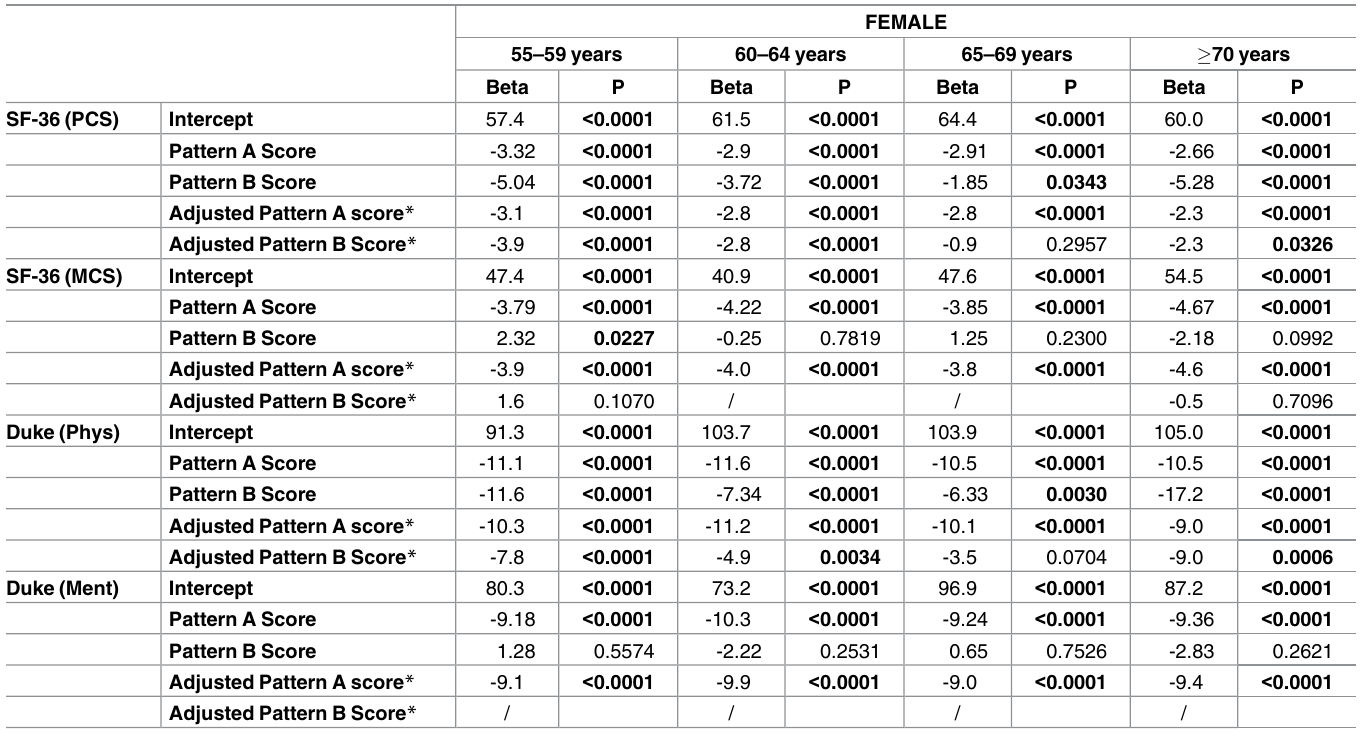
Table 6. Impact of multimorbidity on HRQoL for